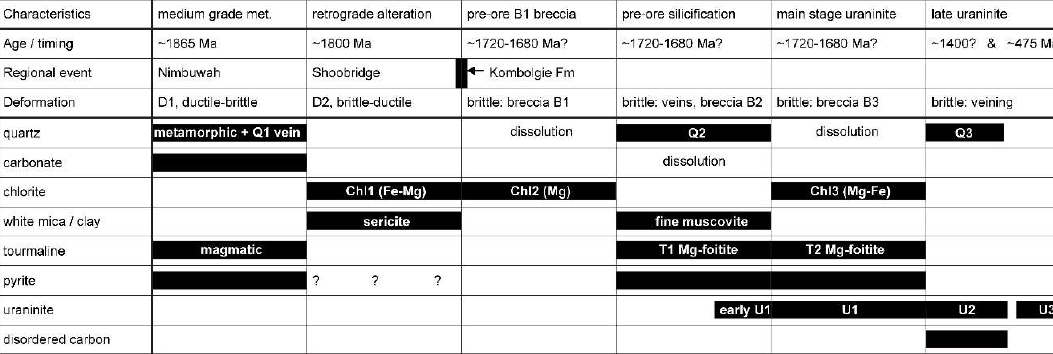
Figure 3. Simplified paragenetic sequence of the Ranger U deposit (Australia) with a focus on the successive generations of tourmaline, chlorite, quartz and uraninite (after Skirrow et al. [4]). Here, chemical and boron isotopic analyses were carried out on tourmaline T1 and chemical analyses were carried out on chlorite Chl2.